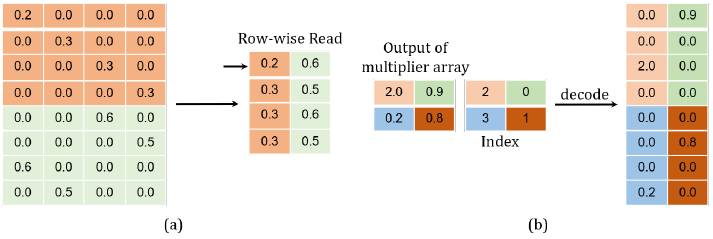
Figure 14. Process involving ( a ) data allocation into a weight memory; ( b ) data decoding into a recovered form.